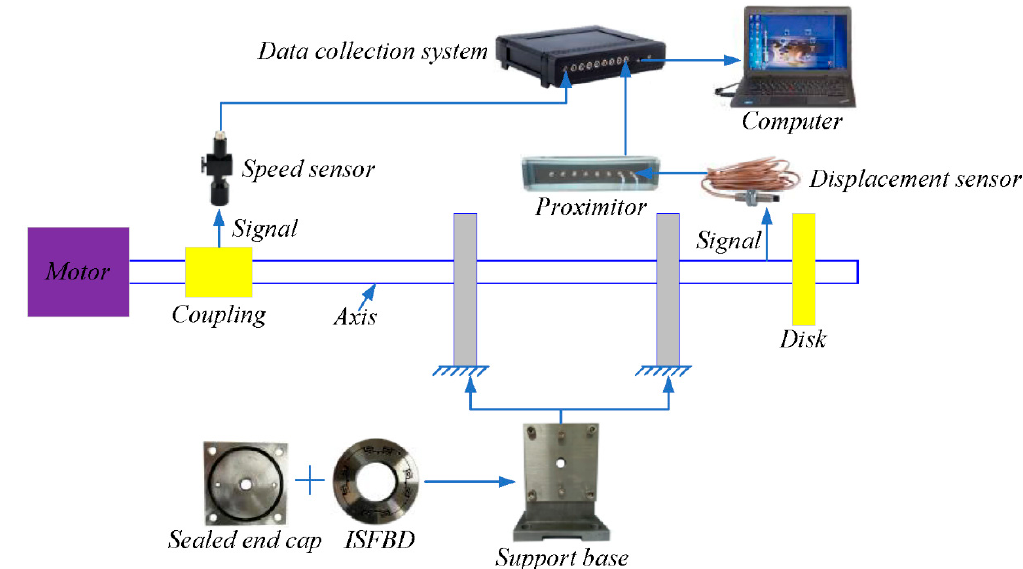
Figure 9. Schematic diagram of vibration control test platform for an unbalanced single-side Figure9. Schematicdiagramofvibrationcontroltestplatformforanunbalancedsingle-sidecantilevered cantilevered system with ISFBD. system with